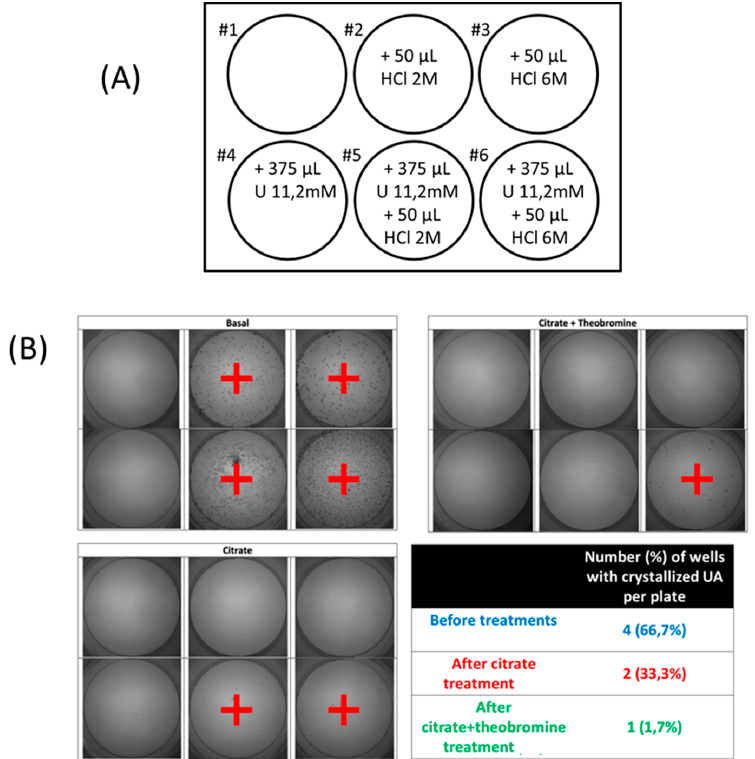
Figure 2. ( A ) Protocol board diagram to establish the risk of crystallization or uric acid (RUAC). Six wells of a 12-well plate were used for each sample of urine, with each well containing 5 mL of urine and di ff erent amounts of HCL and urate. Well #1 had urine alone, well #2 had urine and 50 µ L of 2